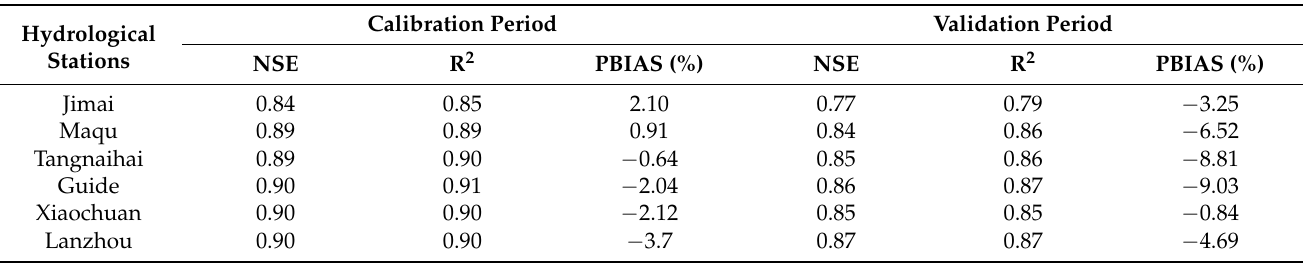
Table 4. Validation of annual runoff series simulated by the SWAT model in the upper Yellow River